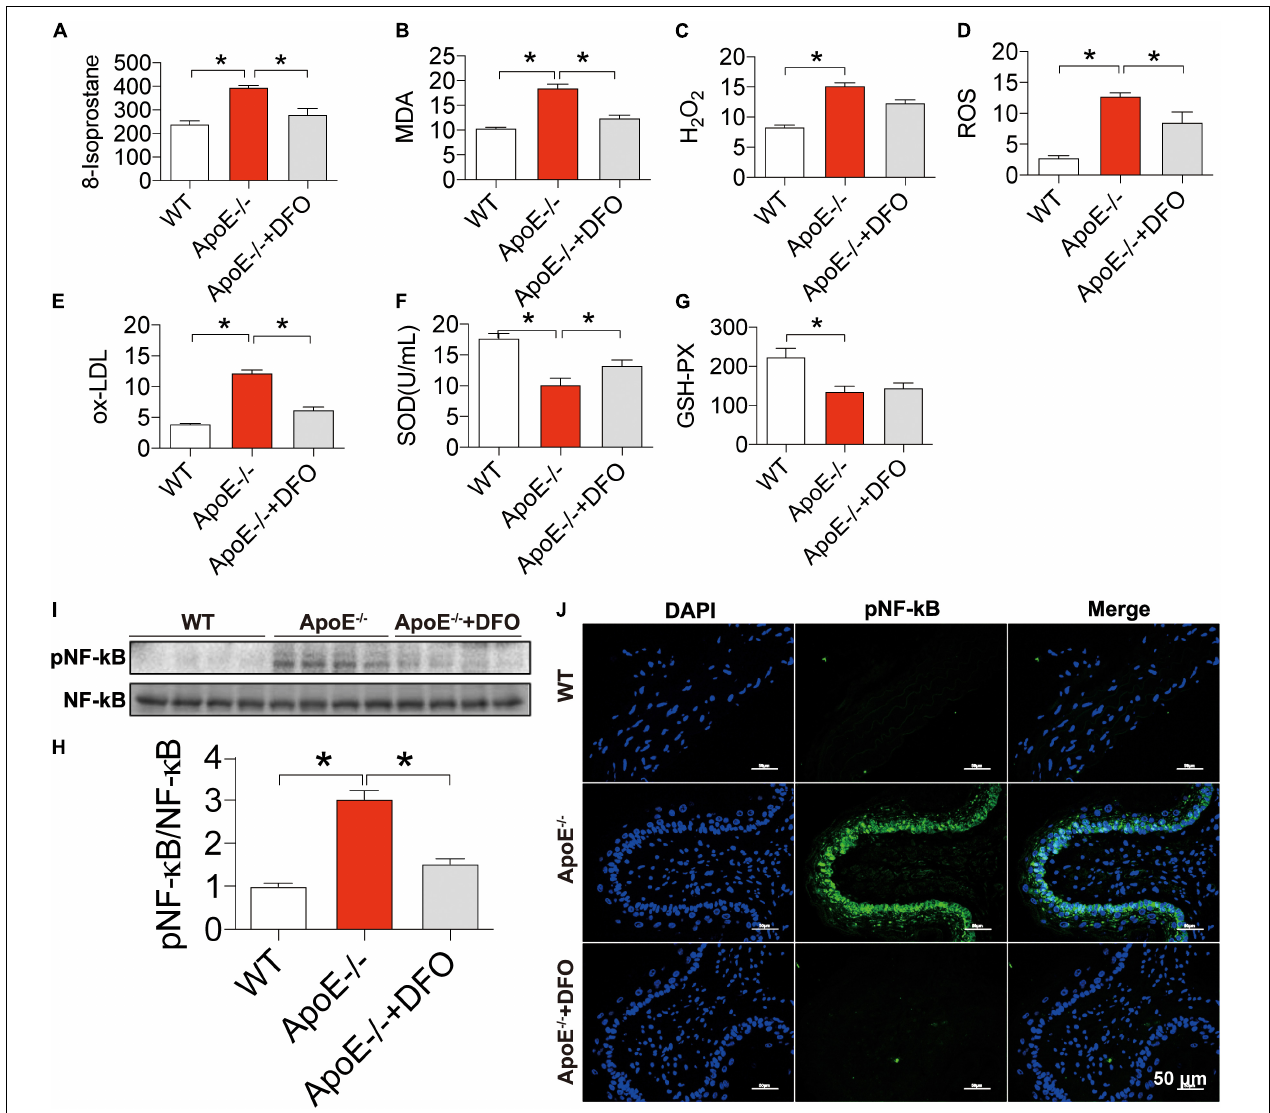
FIGURE 6 | Increased production of reactive oxygen species, NF- κ B phosphorylation and reduced SOD and GSH-PX contents in ApoE deficient mice. The contents of 8-isoprostane (pg/mL) (A) , MDA (nmol/mL) (B) , H 2 O 2 (nmol/mL) (C) , ROS (Fold of the Control) (D) and ox-LDL ( µ g/mL) (E) , SOD (U/mL) (F) and GSH-PX (G) in the blood, and NF- κ B phosphorylation [ (H,I) NF-kB family contains five members: p50 (NF-kB1), p52 (NF-kB2), p65 (RelA), c-Rel, and RelB, and panel (J) ] in the aortic tissues were determined by the procedures as described in section “Materials and Methods” in WT ( n = 8), ApoE – / – ( n = 8) and ApoE – / – + DFO ( n = 8) mice, all aged 28 week-old. The mice in ApoE – / – + DFO group received daily i.p. injections of 100 mg/kg body weight (b.w.) of DFO in HBSS for 14 days. Scale bar in panel (J) = 50 µ m. Data are presented as the mean ± SEM. * p <